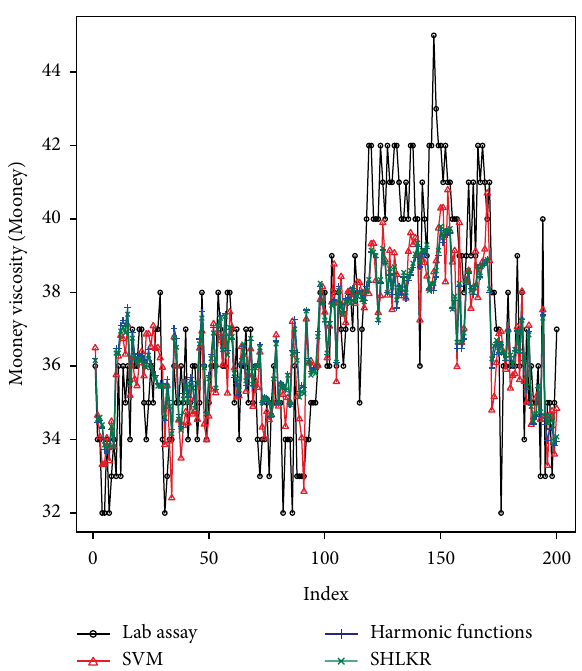
Figure 4: Predictive results of all three different